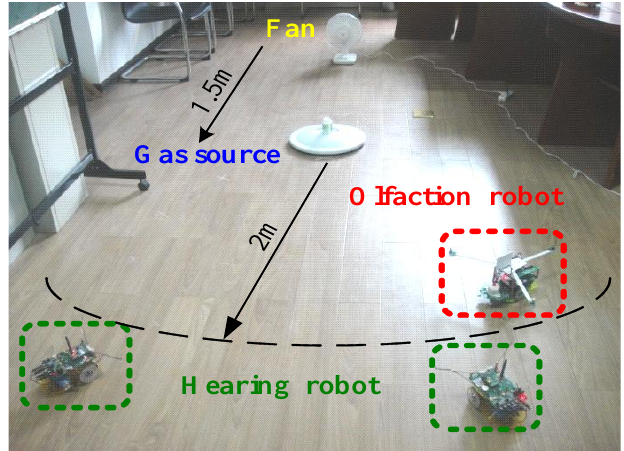
Figure 9. Photograph of the experimental environment.